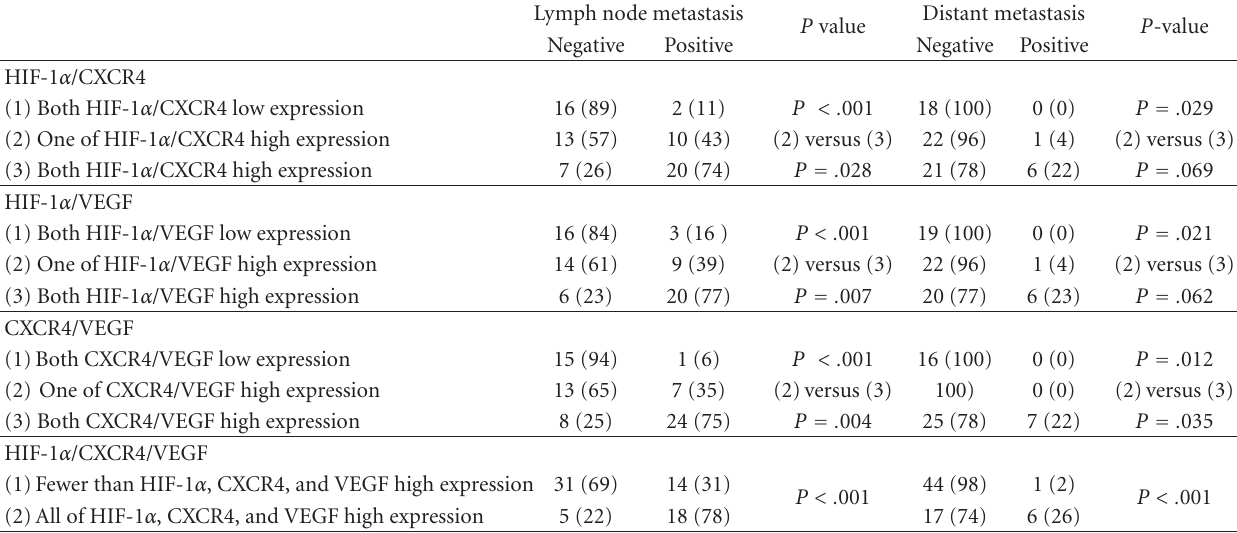
Table 2: Correlation of combined high expression of HIF-1 α , CXCR4, and VEGF with lymph node status and distant